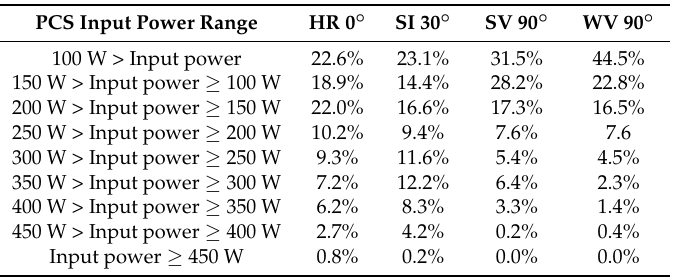
Table 9. Ratio of the time to the PCS input power